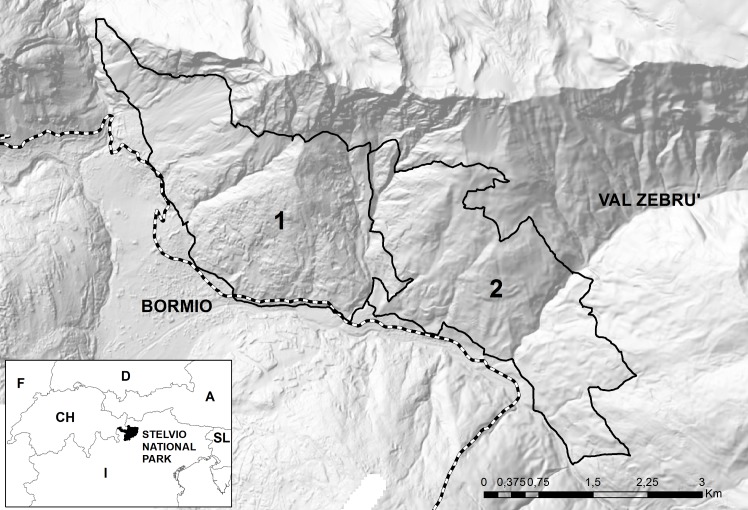
Representation of the two sampling areas (black continuous line), 1 and 2; dotted line: limits of Stelvio National Park.Reprinted from the Stelvio National Park Information System under a CC BY license, with permission from Stelvio National Park, original copyright 2015 (S1 Text).